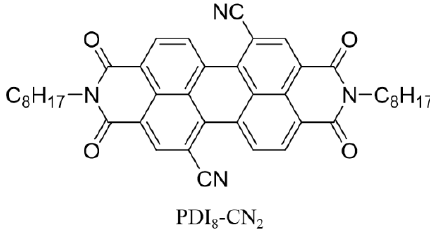
Figure 1. Chemical structure of PDI 8 -CN 2 .